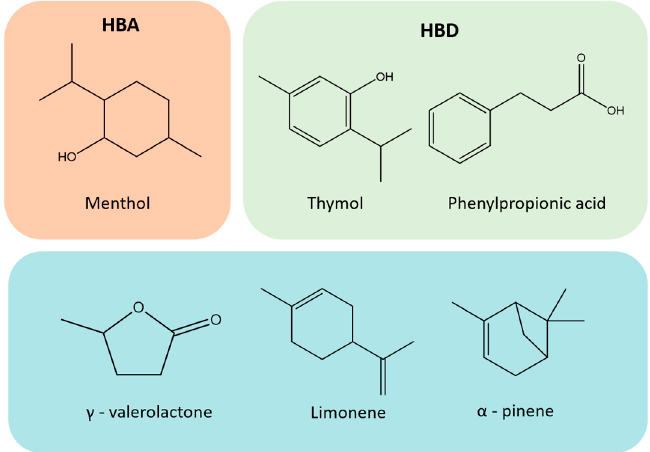
Figure 2. Chemical structures the individual components of the deep eutectic solvents (DES) prepared, as well as other bio-based solvents used in this work.